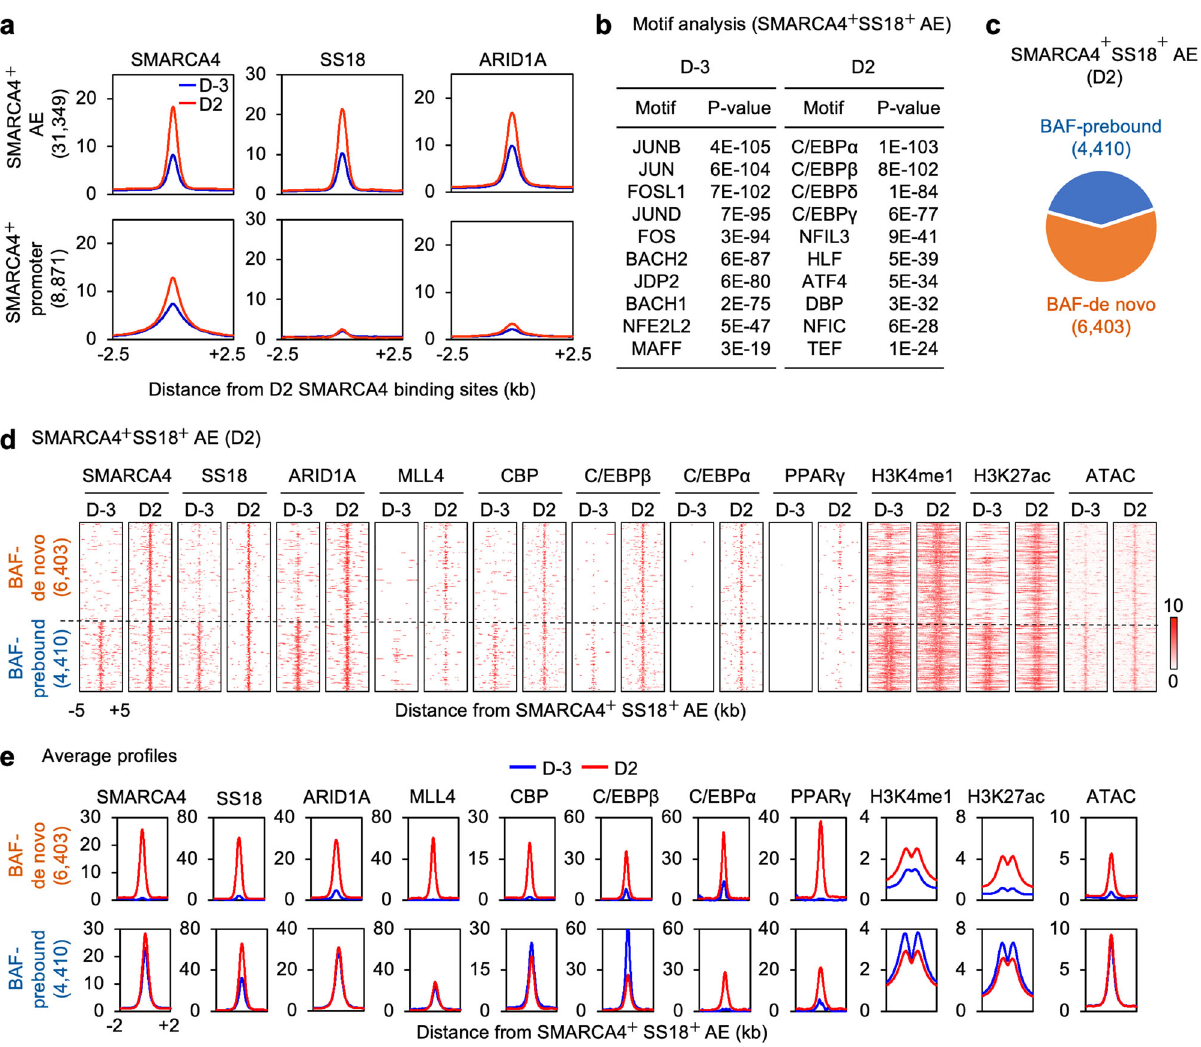
Fig. 3 BAF co-localizes with LDTFs and MLL4 on active enhancers during adipogenesis. a Average binding pro fi les of SMARCA4, SS18, and ARID1A around the center of SMARCA4 + active enhancers (AEs) or promoters before (D-3) and during (D2) adipogenesis of brown preadipocytes. Normalized read counts are shown. b Motif analysis of the top 3,000 SMARCA4 + SS18 + AEs using SeqPos motif tool. c Pie chart depicting BAF-binding (SMARCA4 + SS18 + ) AEs at D2 of adipogenesis. Among the 10,813 BAF-binding AEs at D2, 6,403 are de novo BAF-binding AEs (BAF-de novo), while 4,410 AEs are already bound by BAF (BAF-prebound) at D-3. d , e BAF subunits SMARCA4, SS18 and ARID1A colocalize with LDTFs (C/EBP β , C/EBP α , and PPAR γ ), MLL4, CBP and open chromatin on AEs (H3K4me1 + H3K27ac + ) at D2 of adipogenesis. The local epigenetic environment exhibits coordinated changes during differentiation. Heat maps ( d ) and average pro fi les ( e ) were aligned around the center of SMARCA4 + SS18 + AEs. Published ChIP-Seq data sets for MLL4, CBP, C/EBP β , C/EBP α , and PPAR γ were used (GSE74189) 18